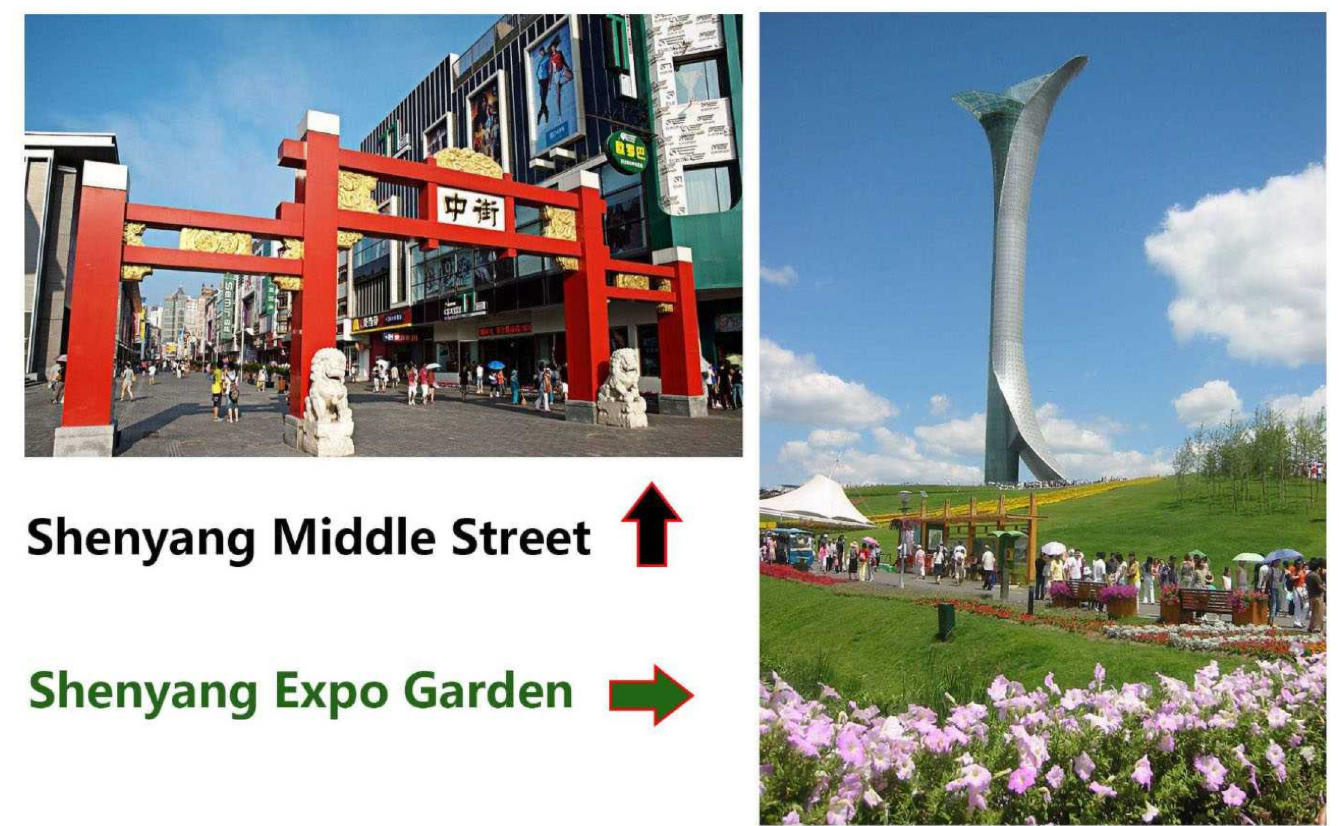
Fig 1. Shenyang Expo Garden (forest) and Shenyang Middle Street (Promenade or Urban) in Shenyang City, Northeast China.